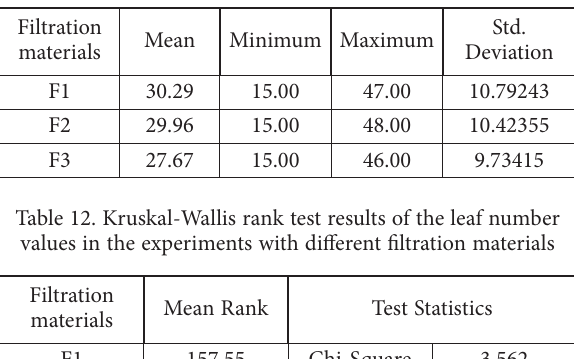
Table 13. Ordinal distribution of factors compared by filtration materials (1: best; 3: worst) Filter materials